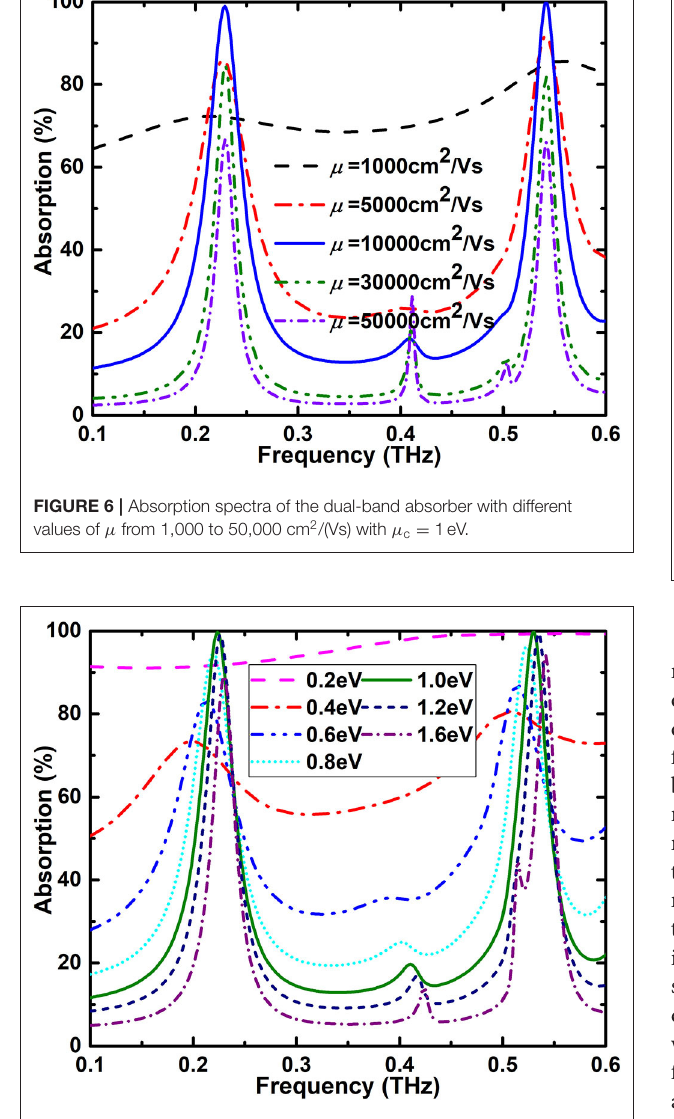
FIGURE 7 | Relationship between the absorptivity and frequency with different chemical potentials from 0.2 to 1.6eV.